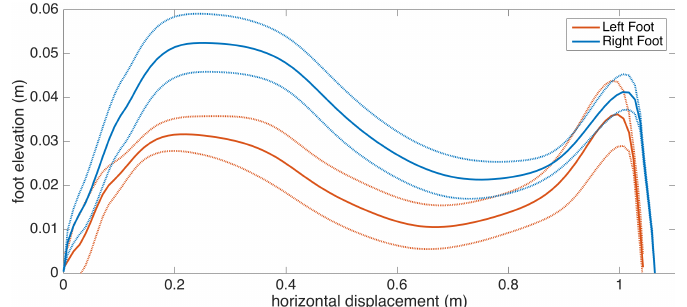
Figure 16. Feet elevation (clearance) asymmetry (Subject